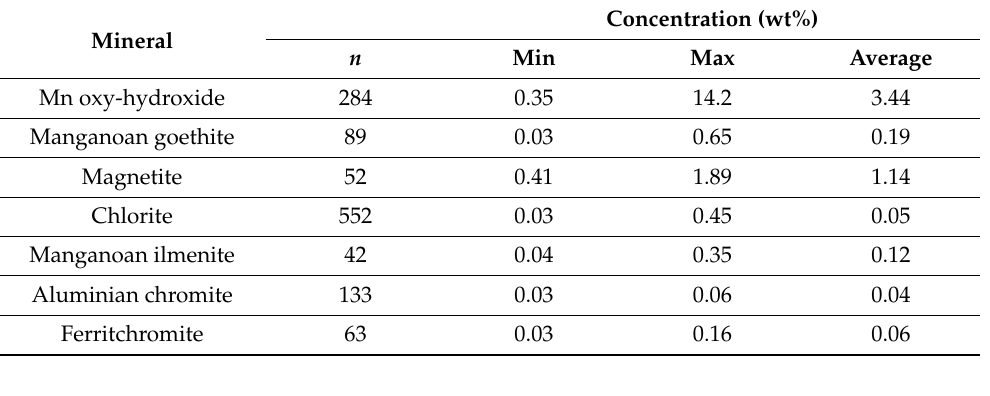
Table 6. Host minerals for Co in the Piau í laterite profile. n = the total number of points analysed for each mineral across all samples tested. The average levels of MnO in manganoan goethite is 1.29 wt%, in manganoan ilmenite is 24.4 wt%, in aluminian chromite is 0.20 wt% and in ferritchromite is 2.67 wt%. Data are from EMPA analysis.